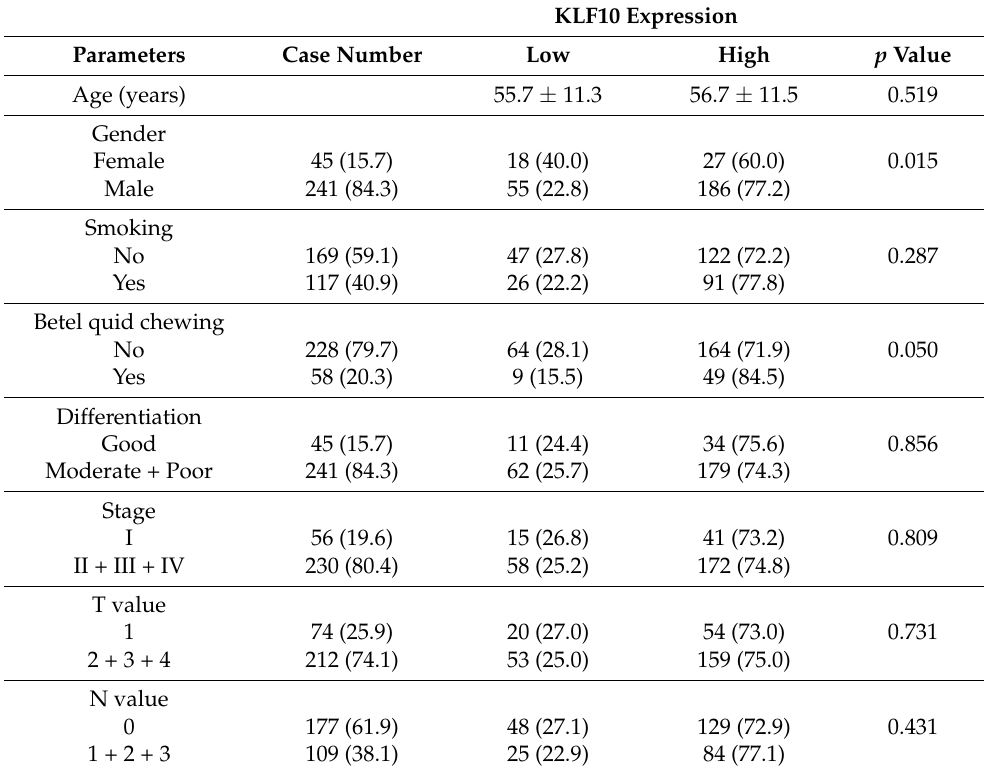
Table 1. The relationships between Krüppel-like transcription factor 10 (KLF10) expression and clinical parameters in oral cancer